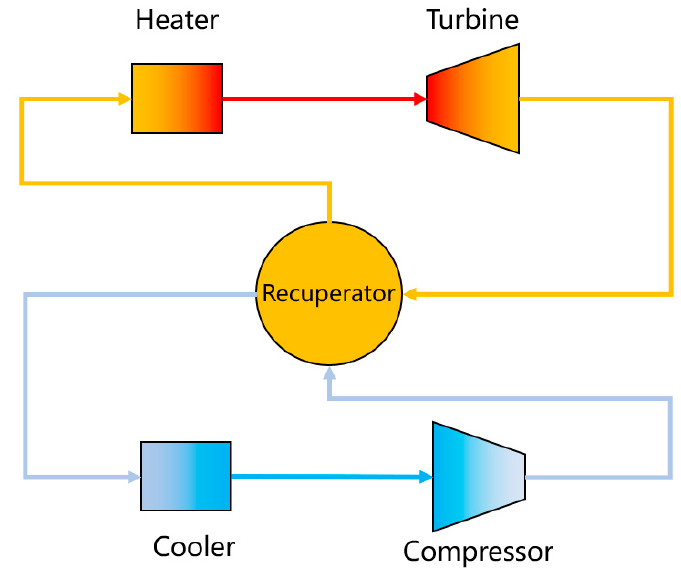
Figure 1. The simple reheat cycle. Cycle parameters are shown in Table 1. The heat source power is over 5 MWth, the turbine inlet temperature is 550 ◦ C and the turbine inlet pressure is 20 MPa. The compressor inlet parameters depart slightly from the critical point but are near the pseudo-critical line, and the pressure ratio is above 2.5, ensuring that the cycle has an efficiency of at least 21% after accounting for all sorts of losses. Table 1. The main parameters of MWe sCO 2 power cycle.